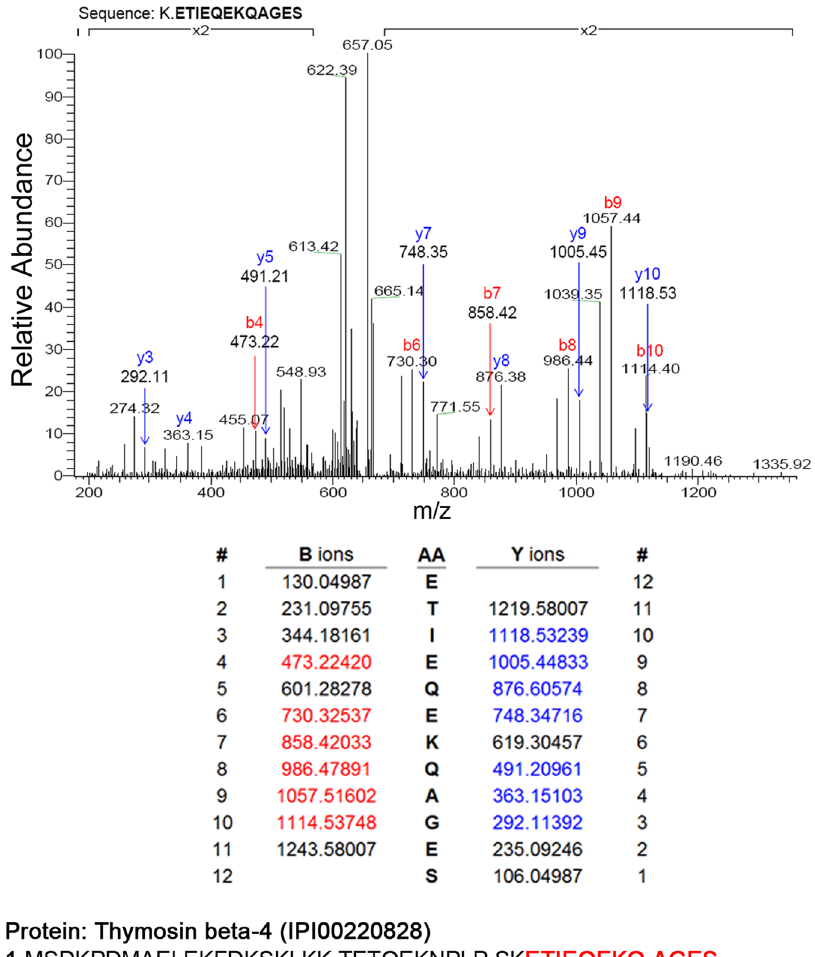
Figure 2. LC-MS/MS analysis of TMSB4X. The data showed sequencing of the trypsinized peptide K.ETIEQKQAGES, which was identified as TMSB4X in CAL27 cell line. Peptide sequencing was indicated by matching B-ions (red) and Y-ions (blue) fragments. B-ions: the charge is retained by the amino-terminal part of the peptide. Y-ions: the charge is retained by the carboxyl-terminal part of the